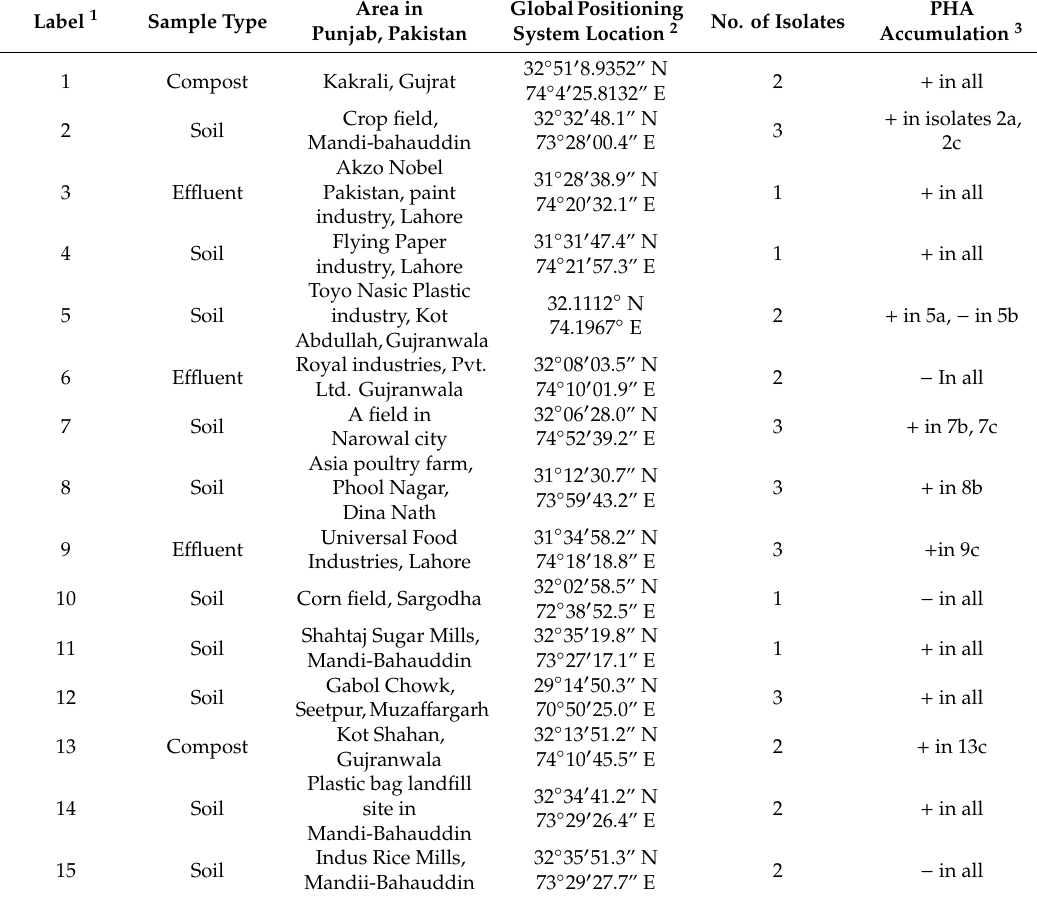
Table 1. Geographical distribution of samples used for the isolation of polyhydroxyalkanoates (PHAs) producing bacteria and the number of positive and negative isolates per